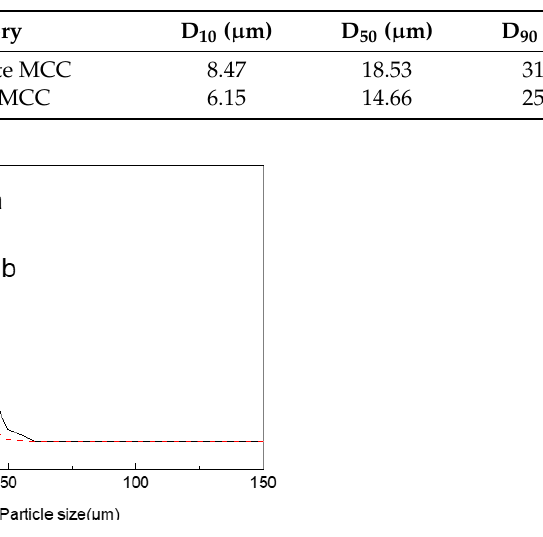
Table 1. Granularity parameter table.